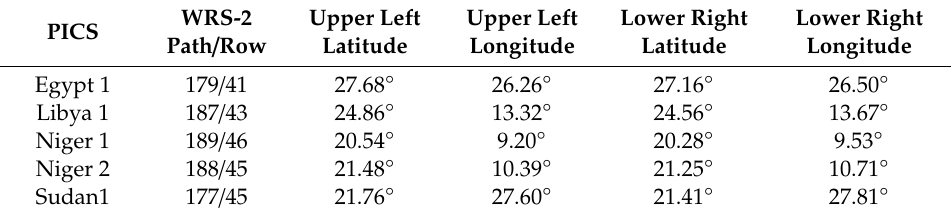
Table 1. Fixed optimal region ROI latitude and longitude